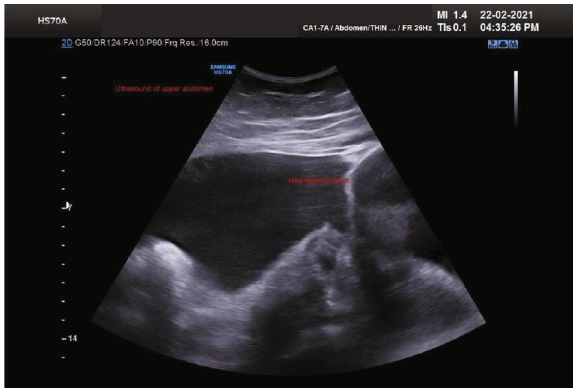
Figure 1: Ultrasound of the upper abdomen showing massive hemoperitoneum.